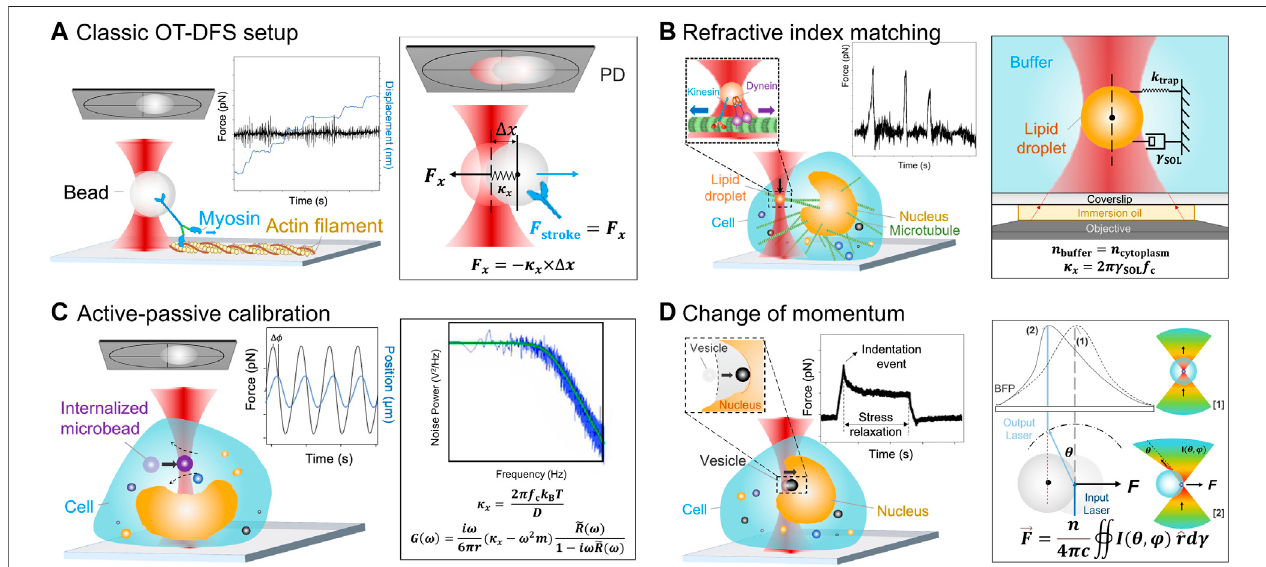
FIGURE 2 | Schematics of the OT force measurement rationales. (A) Classic OT-DFS setup. Left : A representative motor stepping in vitro application is illustrated, whereamyosin( blue )coupledhandlebead( gray )istrappedandbindswithtropomyosinonanactin fi lament( yellow ); leftinset :Myosin ’ sDFSdisplacementvs.time( blue line ) and force vs. time ( black line ) characteristics are shown; right : Force measurement rationale. The trap stiffness κ x is determined by the classic OT force calibration. The displacement of the handle bead Δ x is detected by a QPD ( gray ) [59, 60]. (B) Refractive index matching rationale. Left : A representative intracellular motor stepping application is illustrated, where a lipid droplet ( orange ) is trapped and binds with the intracellular microtubule ( green ); left insets : The lipid droplet ( orange ) is coupled with kinesin ( blue ) and dynein ( purple ), where the kinesin is responsible for transportation from inside out and the dynein is responsible for transportation from outside in. Force vs. time ( black line ) DFS measurements of lipid droplets are shown; right : The force measurement rationale is also shown. Once the lipid droplets are suspended in a refractive index matching buffer, κ x is determined by the corner frequency, f c , and the hydrodynamic drag coef fi cient of the buffer, γ SOL [61, 62]. (C) Active – passive calibration. Left : A representative cytosolic micro-rheology application is illustrated, where the sinusoidal frequency is applied to the intracellular trapped microbead (0.2 – 1 μ m, purple , termed “ internalized microbead ” ); left inset : DFS measurements of the internalized microbead ’ s position vs. time ( blue line ) and force vs. time ( black line ) are shown; right : The force measurement rationale is illustrated. Effective stiffness is determined by active – passive calibration which considers both κ x and the viscoelasticity of the medium G ( ω ) [31, 63]. (D) Change of momentum rationale. Left : A representative intracellular cell nucleus indentation application is illustrated, where a cytosolic vesicle ( black ) is trapped and manipulated to indent the nucleus ( yellow ); left inset : DFS measurements of vesicle ’ s force vs. time ( black line ) are shown; right : Force measurement rationale. With one-off calibration, force is measured based on the change in intensity pro fi le [(1) initial, (2) off-center] [32].